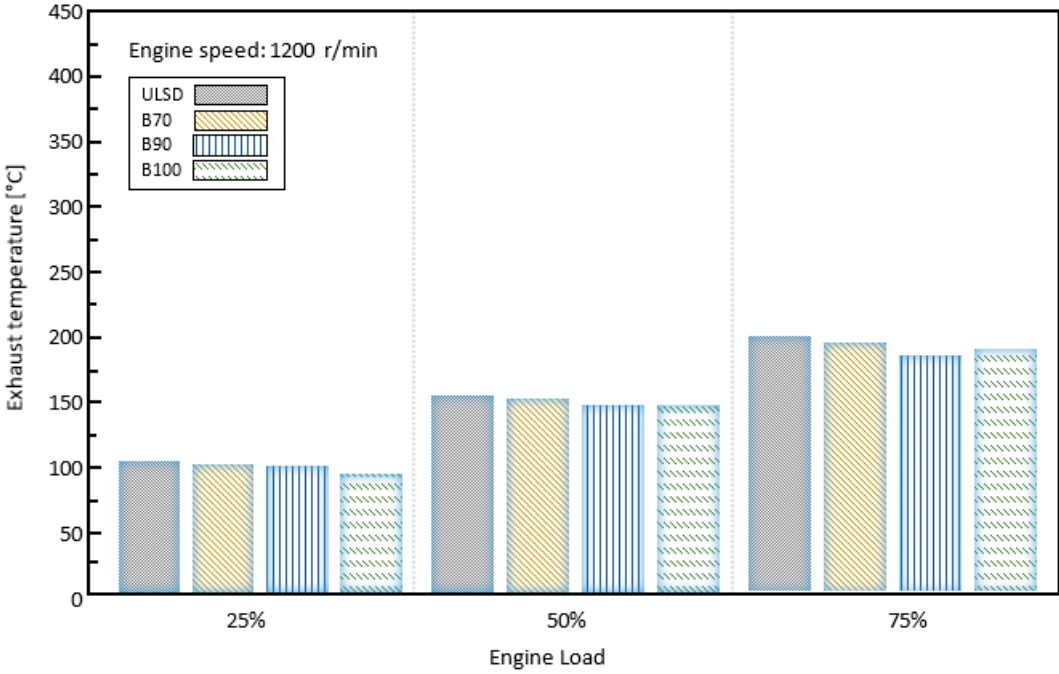
Figure 8. Tested fuels’ influence on the exhaust gas temperature at 1200 rpm.